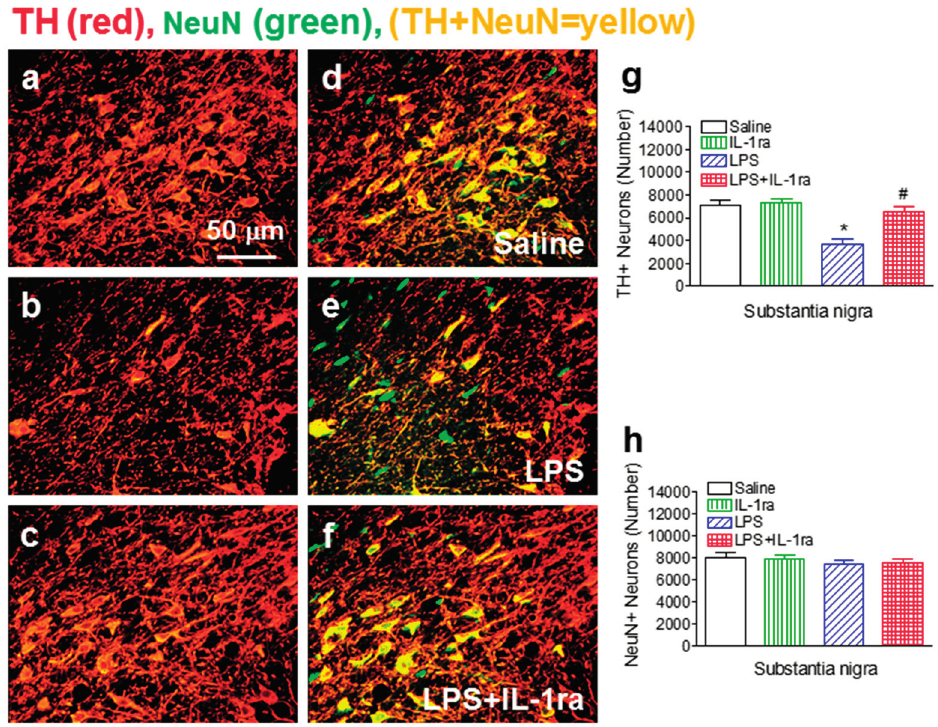
Figure 2. IL-1ra attenuated neonatal LPS-induced reduction on the number of TH+ cells in the SN of P70 rat brain. Representative photomicrographs of TH+ (red color) ( a , b , c ); NeuN+ (green color) cells, or double-labeled cells (yellow) ( d , e , f ) in the SN areas of the midbrain sections; ( a , d ) saline-treated group; ( b , e ) LPS-treated group; ( c , f ) LPS+IL-1ra group; Scale bar: 40 μ m. Stereological quantification of TH+ cells ( g ); and NeuN+ cells ( h ) in the SN area were shown in g and h , respectively. The results are expressed as the mean ± SEM of six animals in each group, and analyzed by two-way ANOVA. * p < 0.05 represents a significant difference for the LPS group as compared with the saline group. # p < 0.05 represents significant difference for the LPS+IL-1ra group as compared with